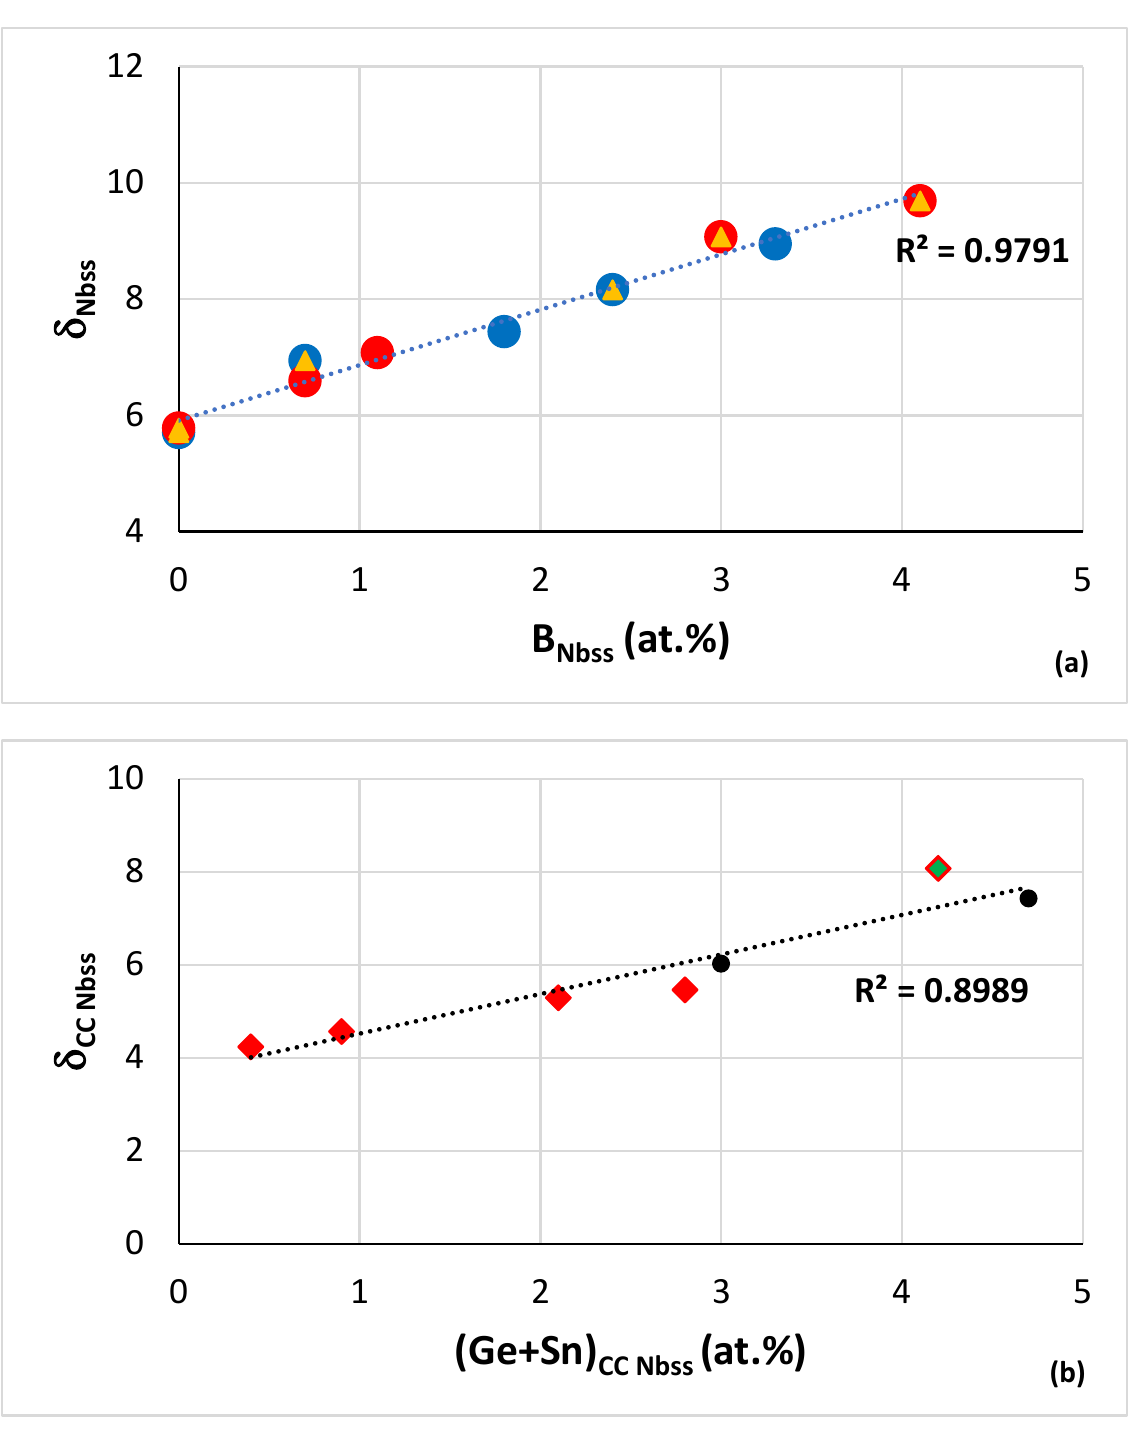
Figure 7. ( a ) Parameter δ of solid solution versus its B concentration. Red data points for CC/HE Nb ss , blue data points for “conventional” Nb ss . Yellow triangles indicate solid solution was formed in RM(Nb)IC/RCCA. All data R 2 = 0.9791, data for CC/HE Nb ss has R 2 = 0 .9884 and data for “con- ventional ” Nb ss has R 2 = 0.9656. Data are as follows: “conventional Nb ss in AC alloys TT4, TT5, TT6, TT7, TT8, CC/HE Nb ss for the AC alloys TT4, TT5, TT7, TT8 and the HT alloy TT5. HE Nb ss in TT4- AC. ( b ) Parameter versus (Ge+Sn) content of CC Nb ss . Data for the AC alloys JZ3, JZ3+ and OHS1